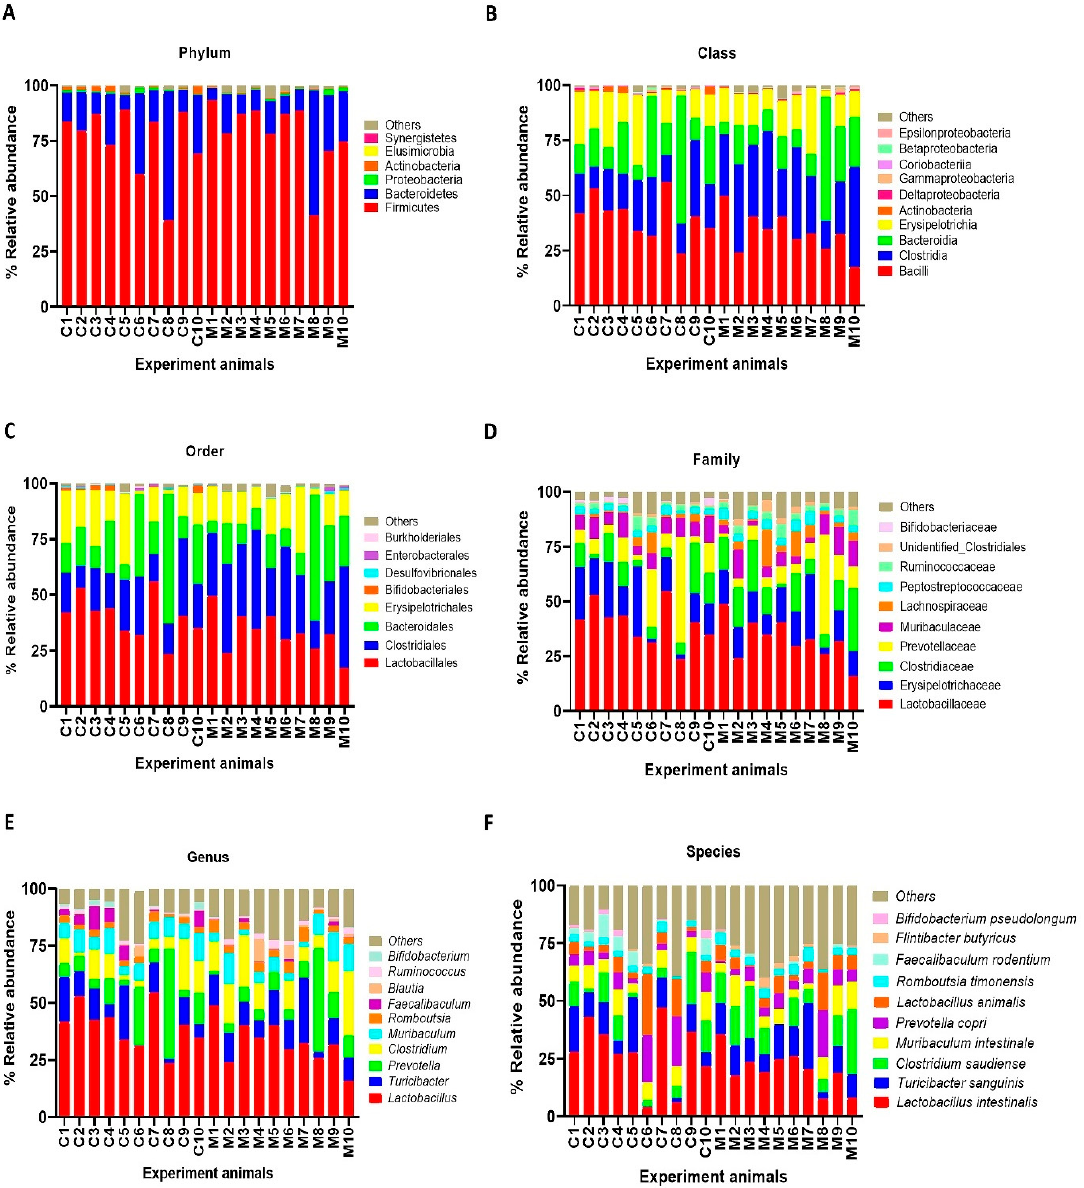
Figure 4. Faecal microbial composition at the different taxonomic levels in MSG-treated (M1–M10) and control (C1–C10) rats. ( A = phylum, B = class, C = order, D = family, E = genus and F = species). Others indicate other bacteria and unidentified bacteria < 5%.